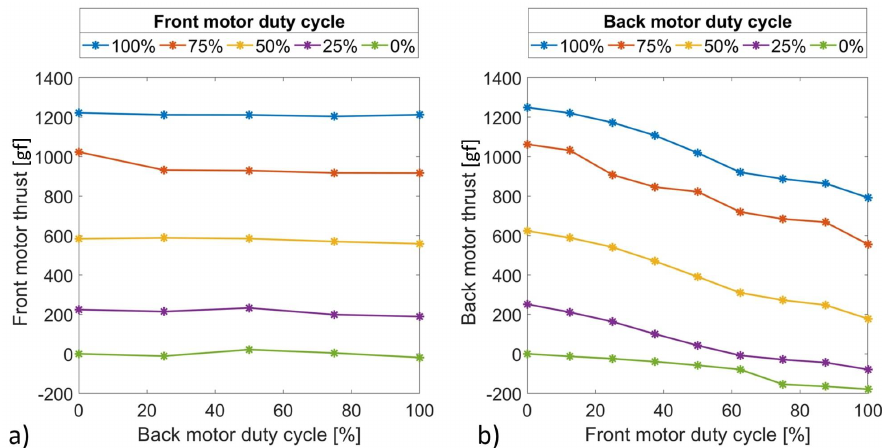
Figure 6. ( a ) Front rotor thrust output while back motor’s duty cycle is incremented. ( b ) Back rotor thrust output while front motor’s duty cycle is incremented.